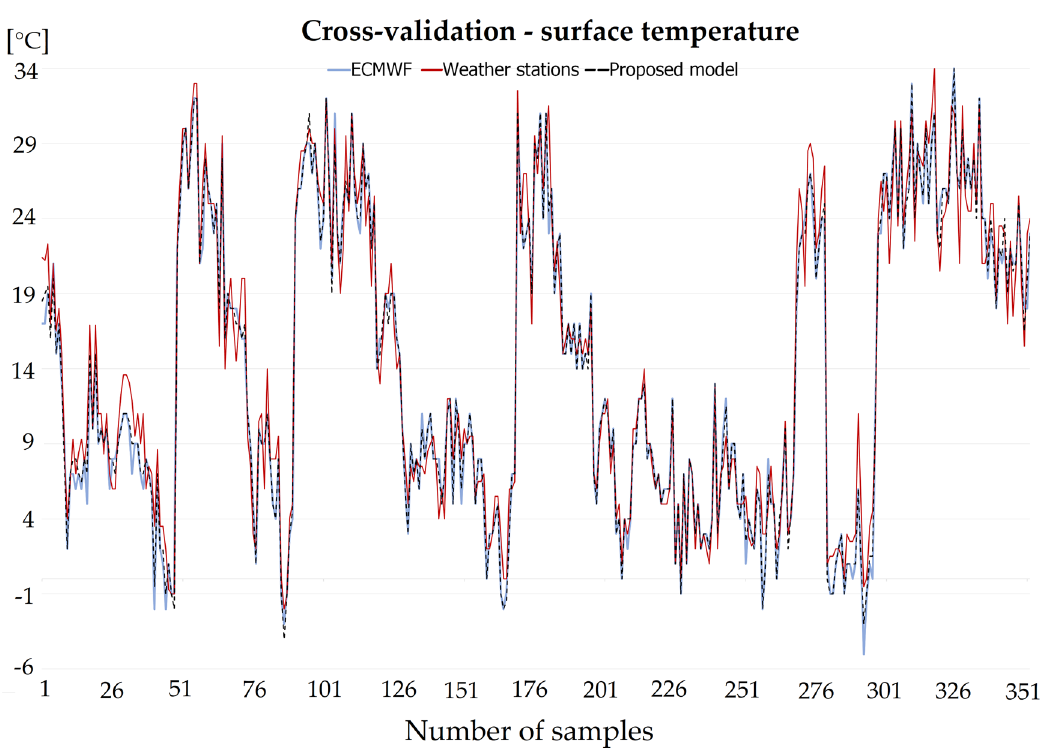
Figure 5. Comparison of predicted surface temperature from the proposed model and ECMWF, and reference temperature from weather